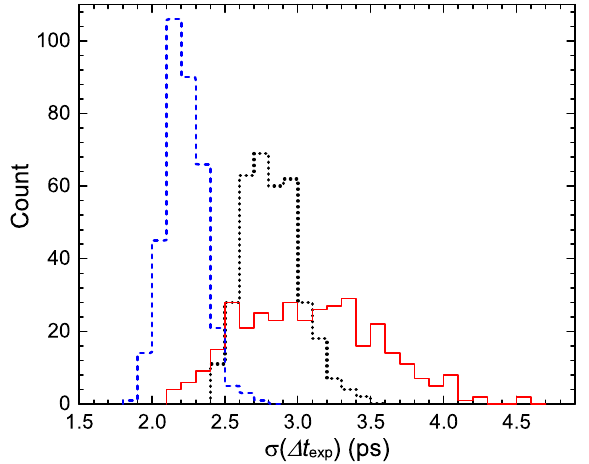
FIG. 11. Average uncertainty of Δ t for all 45 V 23 þ ions exp number (Z), extracted from available Δ t , of the coi circles), and by using the third-order polynomial fit function with [Eq. (7)] (blue filled triangles) and without [Eq. (4)] (red opened circles) the sinelike terms. Solid and dotted lines represent the estimations using Eqs. (8) and (9),